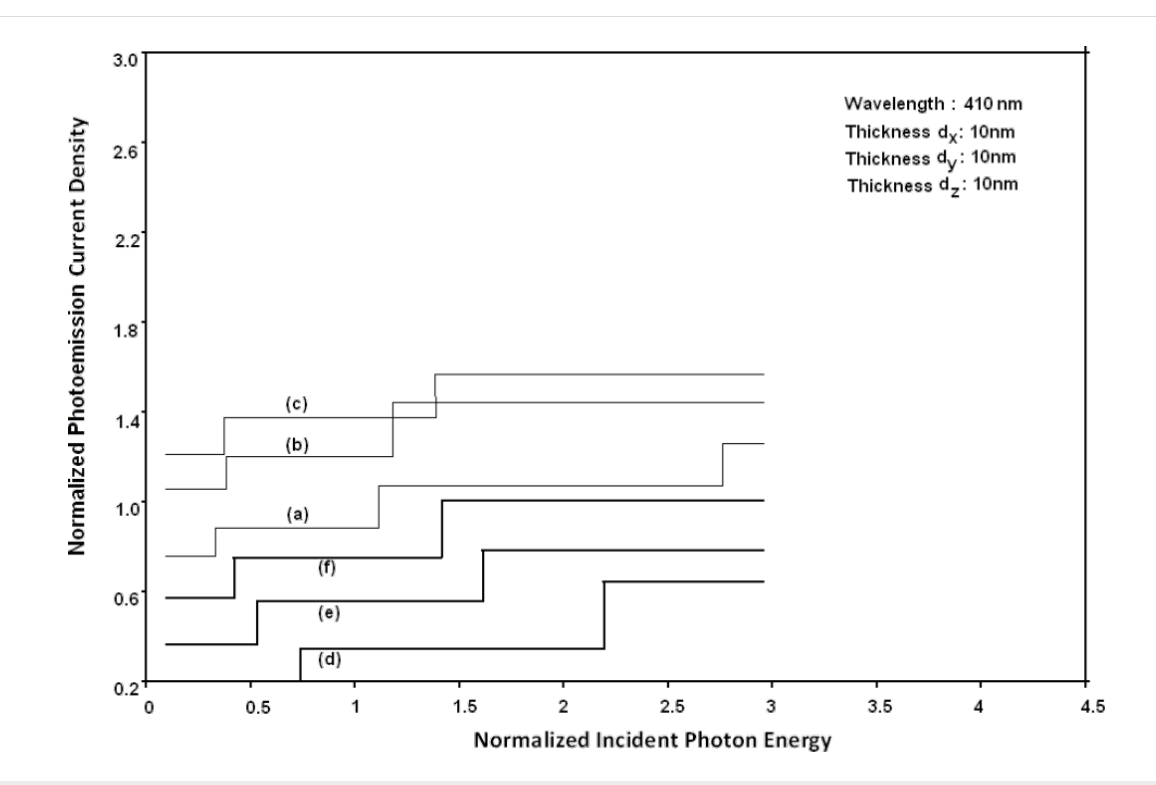
Figure 15: Plot of the normalized photoemission current density from quantum dot effective mass superlattices of HgTe/Hg 1 − x Cd x Te and In x Ga 1 − x As/ InP as a function of normalized incident photon energy for all cases of Figure